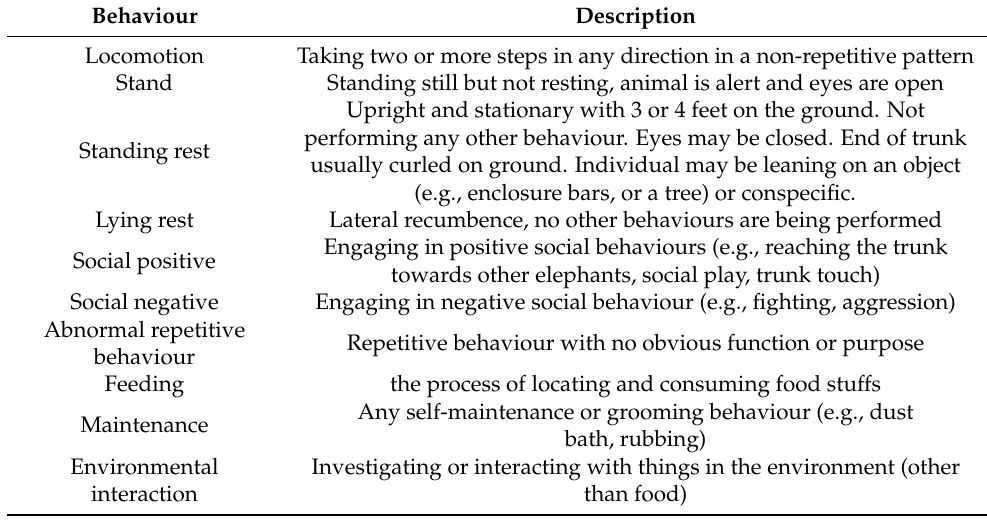
Table 2. Ethogram of behaviours